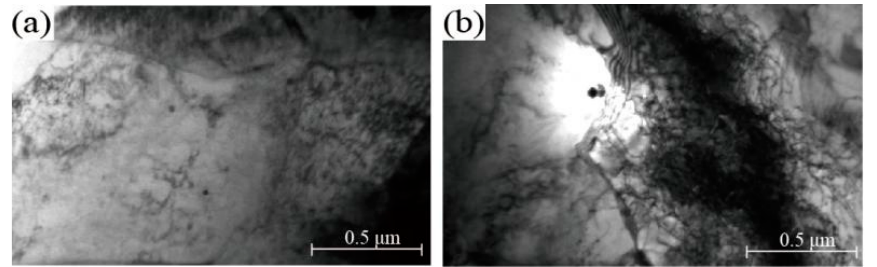
Figure 9. TEM images of the samples at different coiling temperatures: ( a ) 467 °C and ( b ) 403 °C.